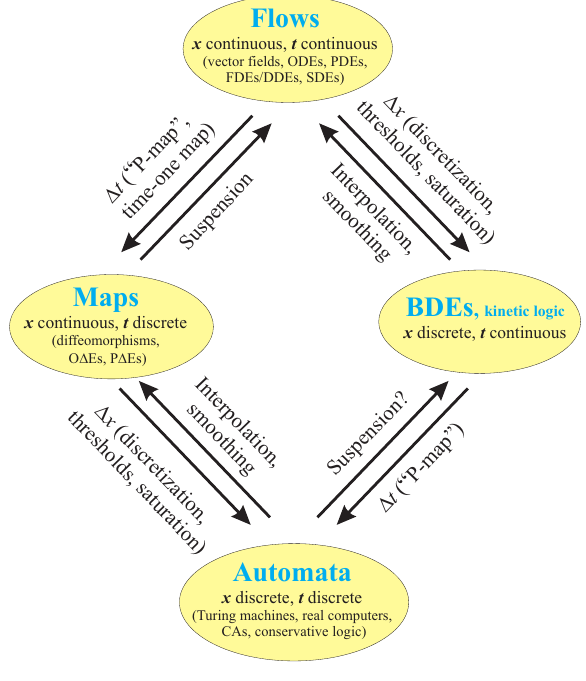
Fig. 3. Dynamical systems and connections between them. Note the links: The discretization of t can be achieved by the Poincar´e map (P-map) or a time-one map, leading from Flows to Maps . The opposite connection is achieved by suspension. To go from Maps to Automata we use the discretization of x . Interpolation and smoothing can lead in the opposite direction. Similar connections lead from BDEs to Automata and to Flows , respectively. Modified after Mullhaupt (1984).